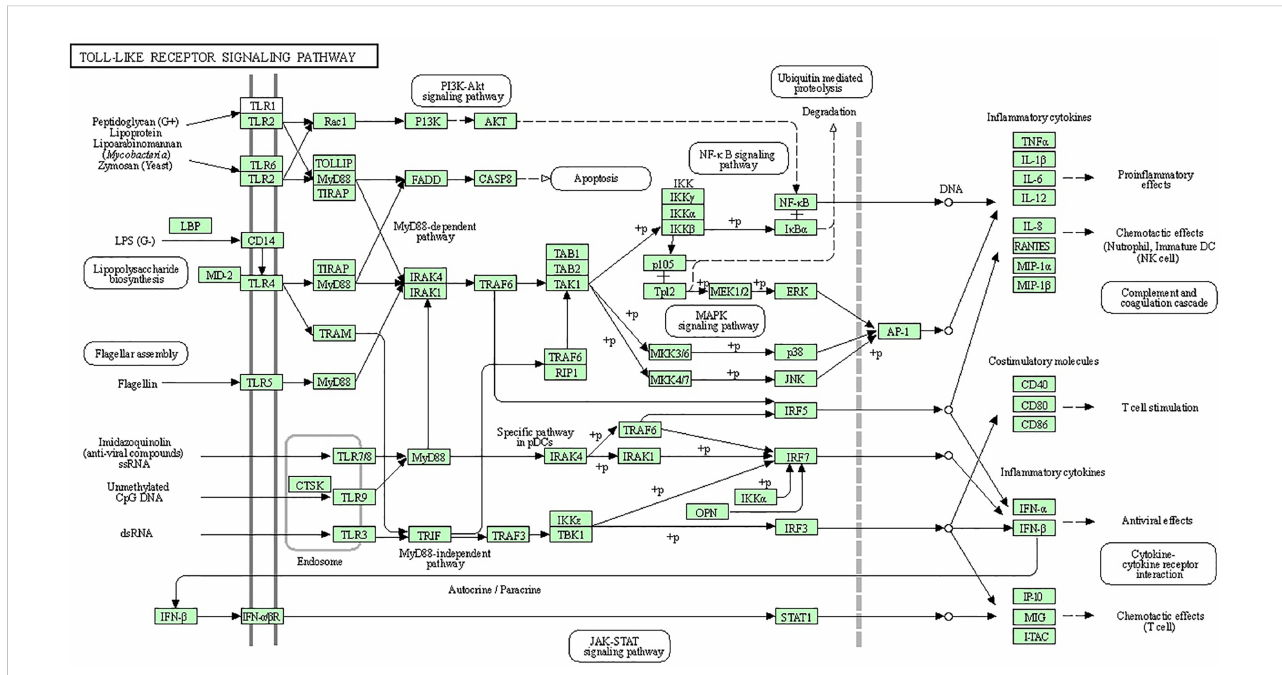
FIGURE 3 Speci fi c families of pattern recognition receptors are responsible for detecting microbial pathogens and generating innate immune responses. Toll-like receptors (TLRs) are membrane-bound receptors identi fi ed as homologs of Toll in Drosophila. Mammalian TLRs are expressed on innate immune cells, such as macrophages and dendritic cells, and respond to the membrane components of Gram-positive or Gram-negative bacteria. Pathogen recognition by TLRs provokes the rapid activation of innate immunity by inducing the production of proin fl ammatory cytokines and the upregulation of costimulatory molecules. TLR signaling pathways are separated into two groups: a MyD88-dependent pathway that leads to the production of proin fl ammatory cytokines with the quick activation of NF-KB and MAPK and a MyD88-independent pathway associated with the induction of IFN-beta and IFN-inducible genes and the maturation of dendritic cells with slow activation of NF-KB and